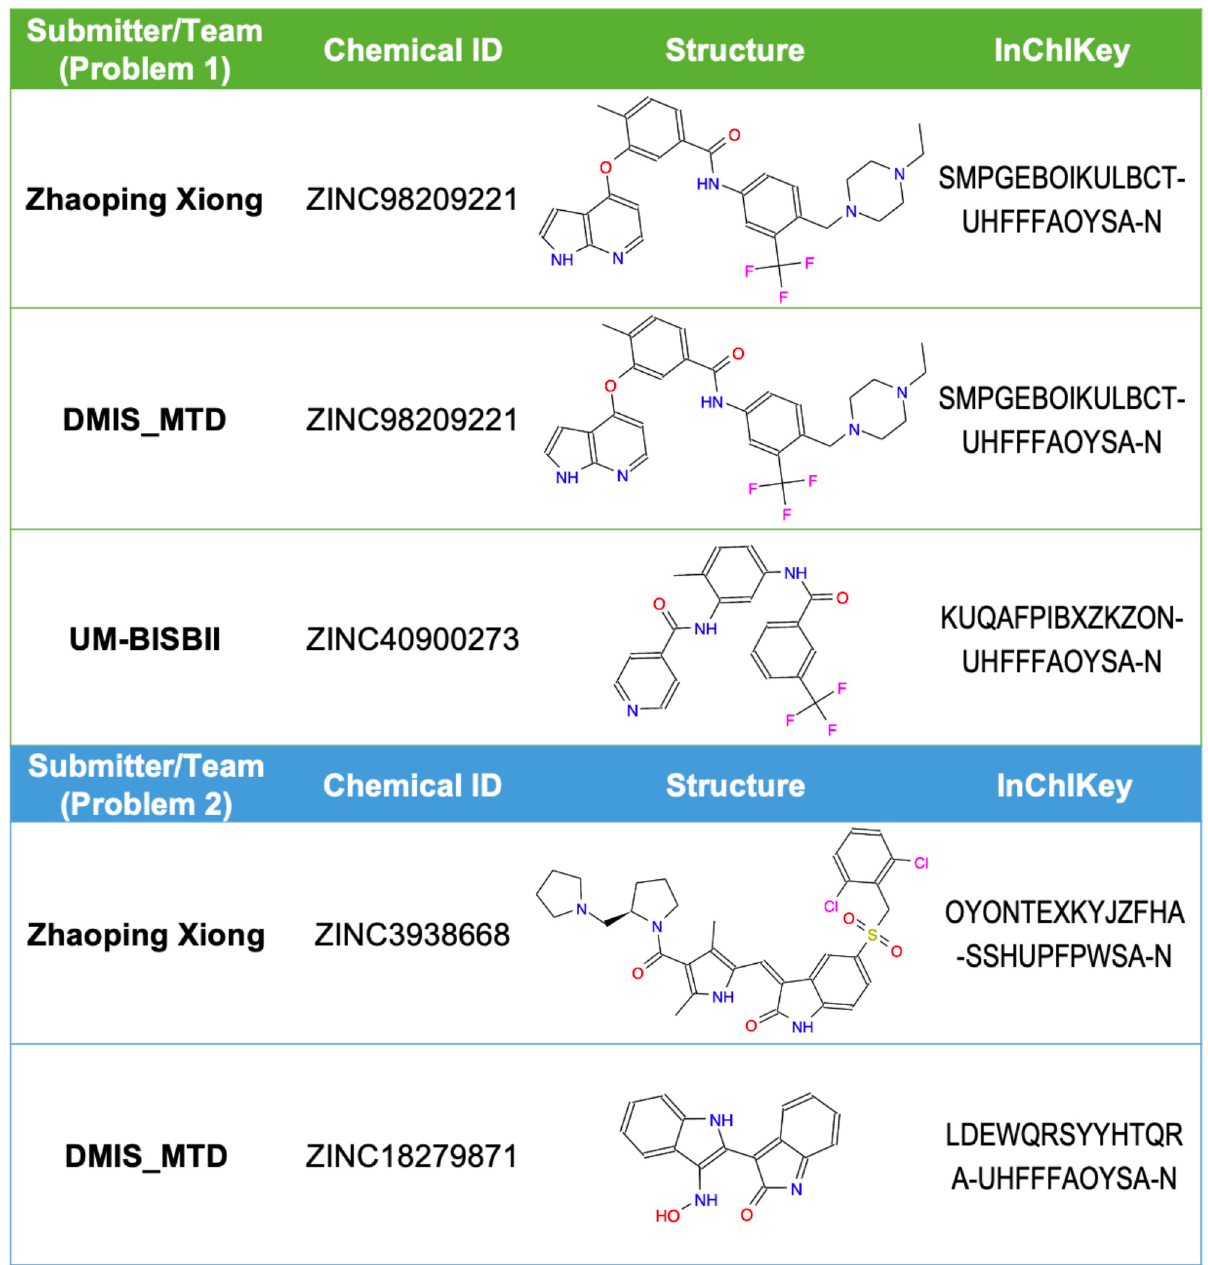
Fig 3. Compounds with activity against Problem 1, 2 targets. “Submitter or Team” indicates the team that identified the compound as a solution to Problem 1 (top) or Problem 2 (bottom) as indicated. “Chemical ID” is the ZINC identifier for the molecule. “Structure” is a two-dimensional representation of the molecule. “InChIKey” is the hashed InChI for the molecule. Strikingly, two teams identified the same molecule as a solution for Problem 1.